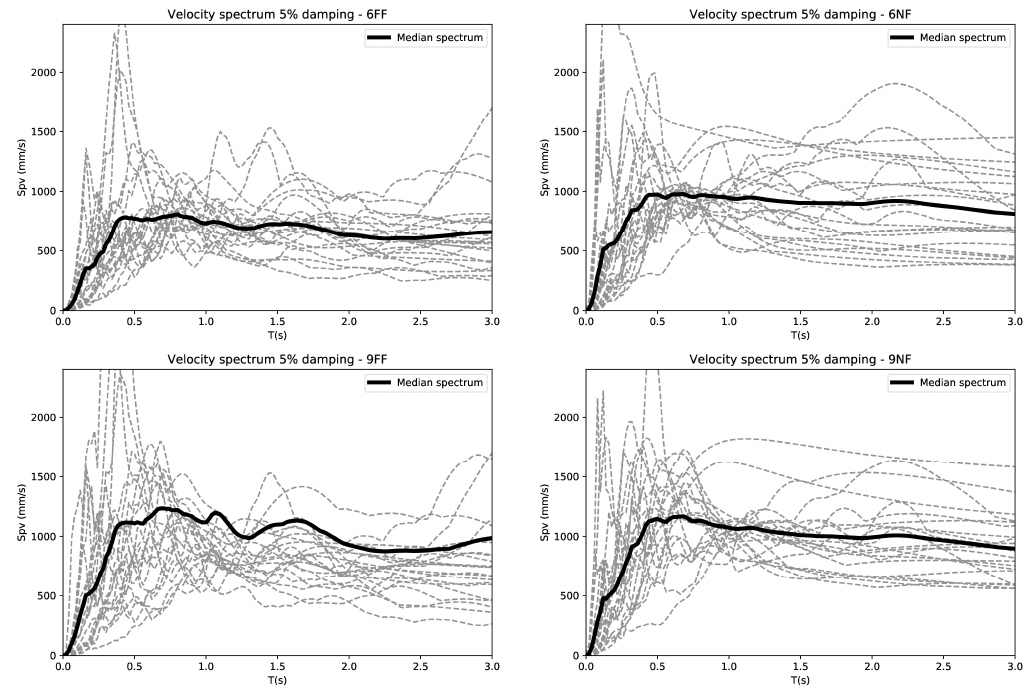
Figure A5. Elastic velocity spectra at 5% damping.